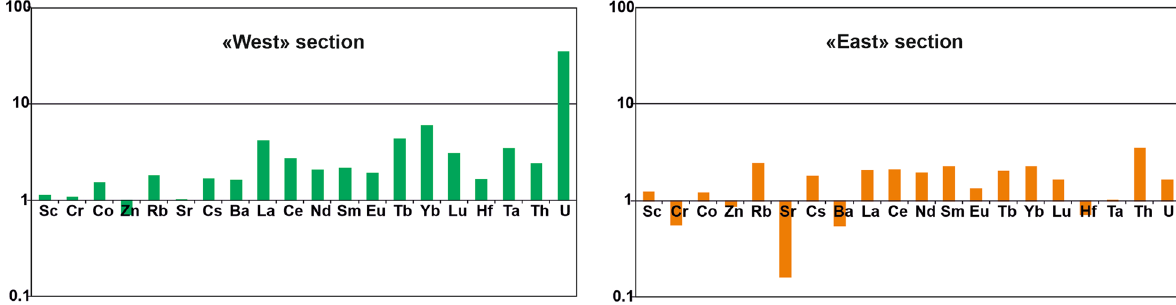
Fig. 3 Average content of impurity elements in ash of the Rakovka depression coals relative to Clarkes in ash of lignite coals of the world (Yudovich and Ketris